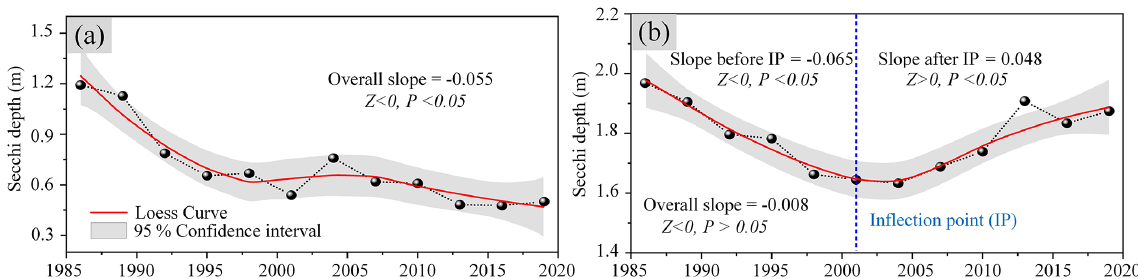
Figure 8. The long-term trend in SD for lakes with an area > 0.01km 2 ( N = 40973) across China from 1985 to 2020. (a) The mean SD of lakes ≤ 1km 2 across China and (b) the mean SD of lakes > 1km 2 across China. Note: IP – inflection